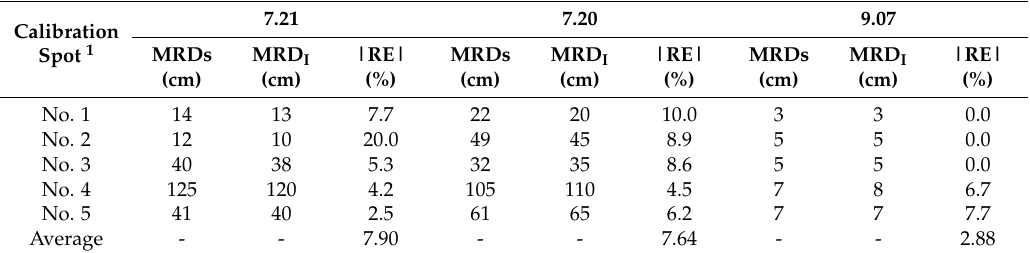
Table 6. Comparison between PT S and PT I of typical runoff processes.